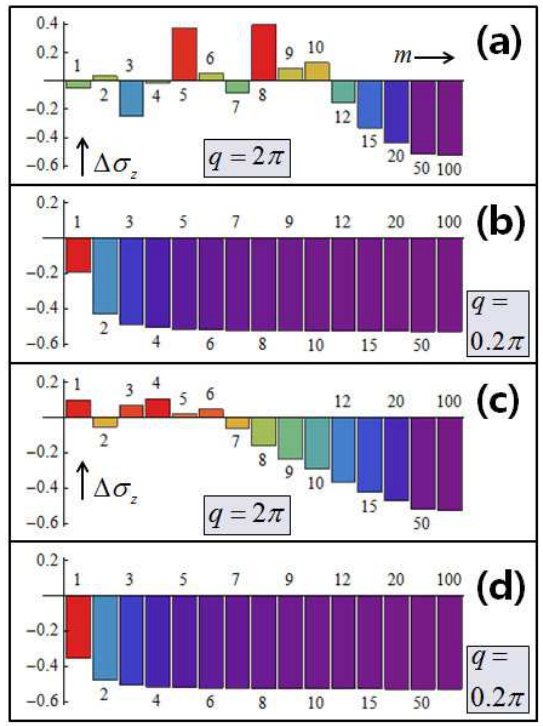
Figure 6: The jump in the specific spin